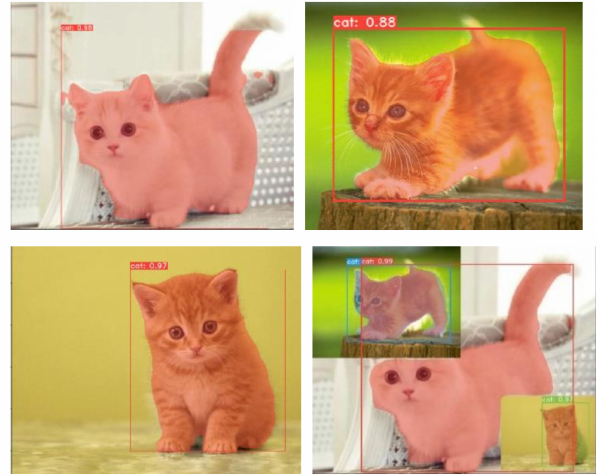
Figure 5. Detection results of single target. The detection effect of the network is very good for the single class target in the simple background, and the detection effect is also good in the case of occlusion when multiple objects in the single class are mixed into one image.